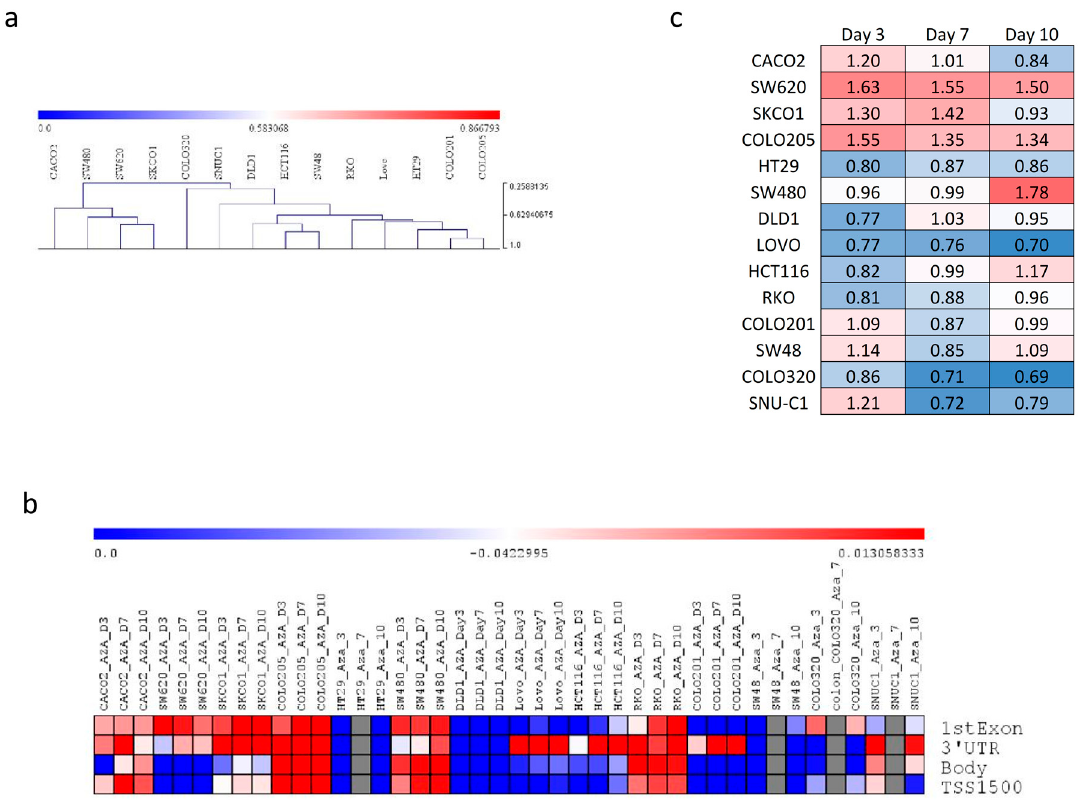
Figure 7. Methylation profiles of colorectal cancer samples as determined in the GSE53051 microarray dataset. Methylation patterns of the KCNMA1 promoter are expressed as Beta values.